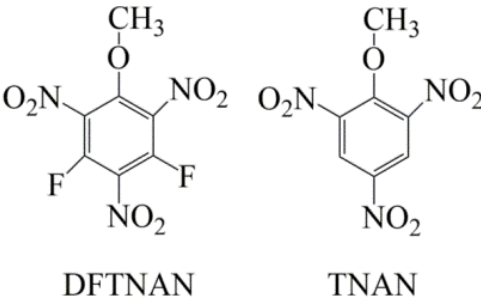
Figure 1. The molecular structures of DFTNAN and TNAN.